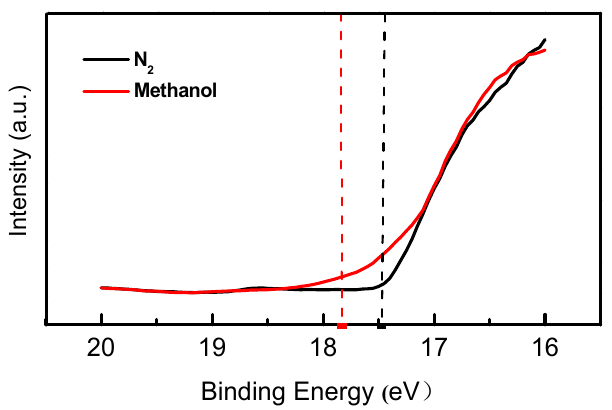
Figure 8. UPS spectra of EML with or without methanol vapor annealing.